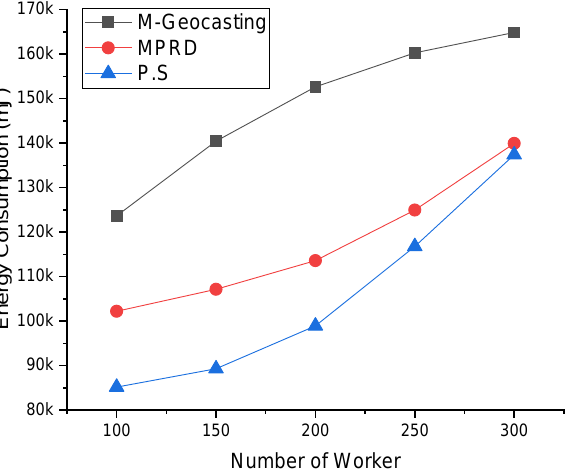
Figure 11. Comparison of energy consumption according to the number of